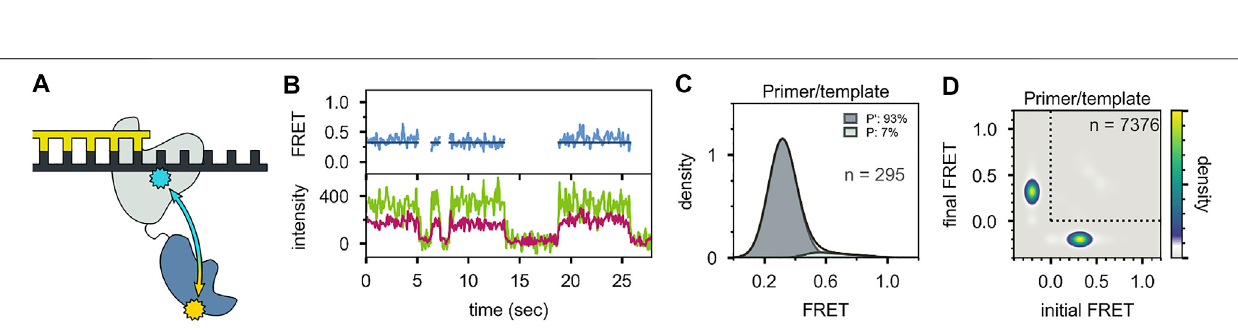
FIGURE 11 | Probing the location of the 5 ′ nuc domain in the absence of a downstream DNA strand. (A) Schematic representation of donor (yellow) and acceptor (blue)sites. (B) Donorintensity(green),acceptorintensity(red)andFRETef fi ciency(blue)tracesareshown.Theblacklineisa fi tfromHiddenMarkovmodeling. (C) FRET ef fi ciency histogram compiled from n trajectories, separated into states P ′ and P. (D) Transition probability density plot, compiled from n transitions. Reproduced from reference (Pauszek et al., 2021) with permission.